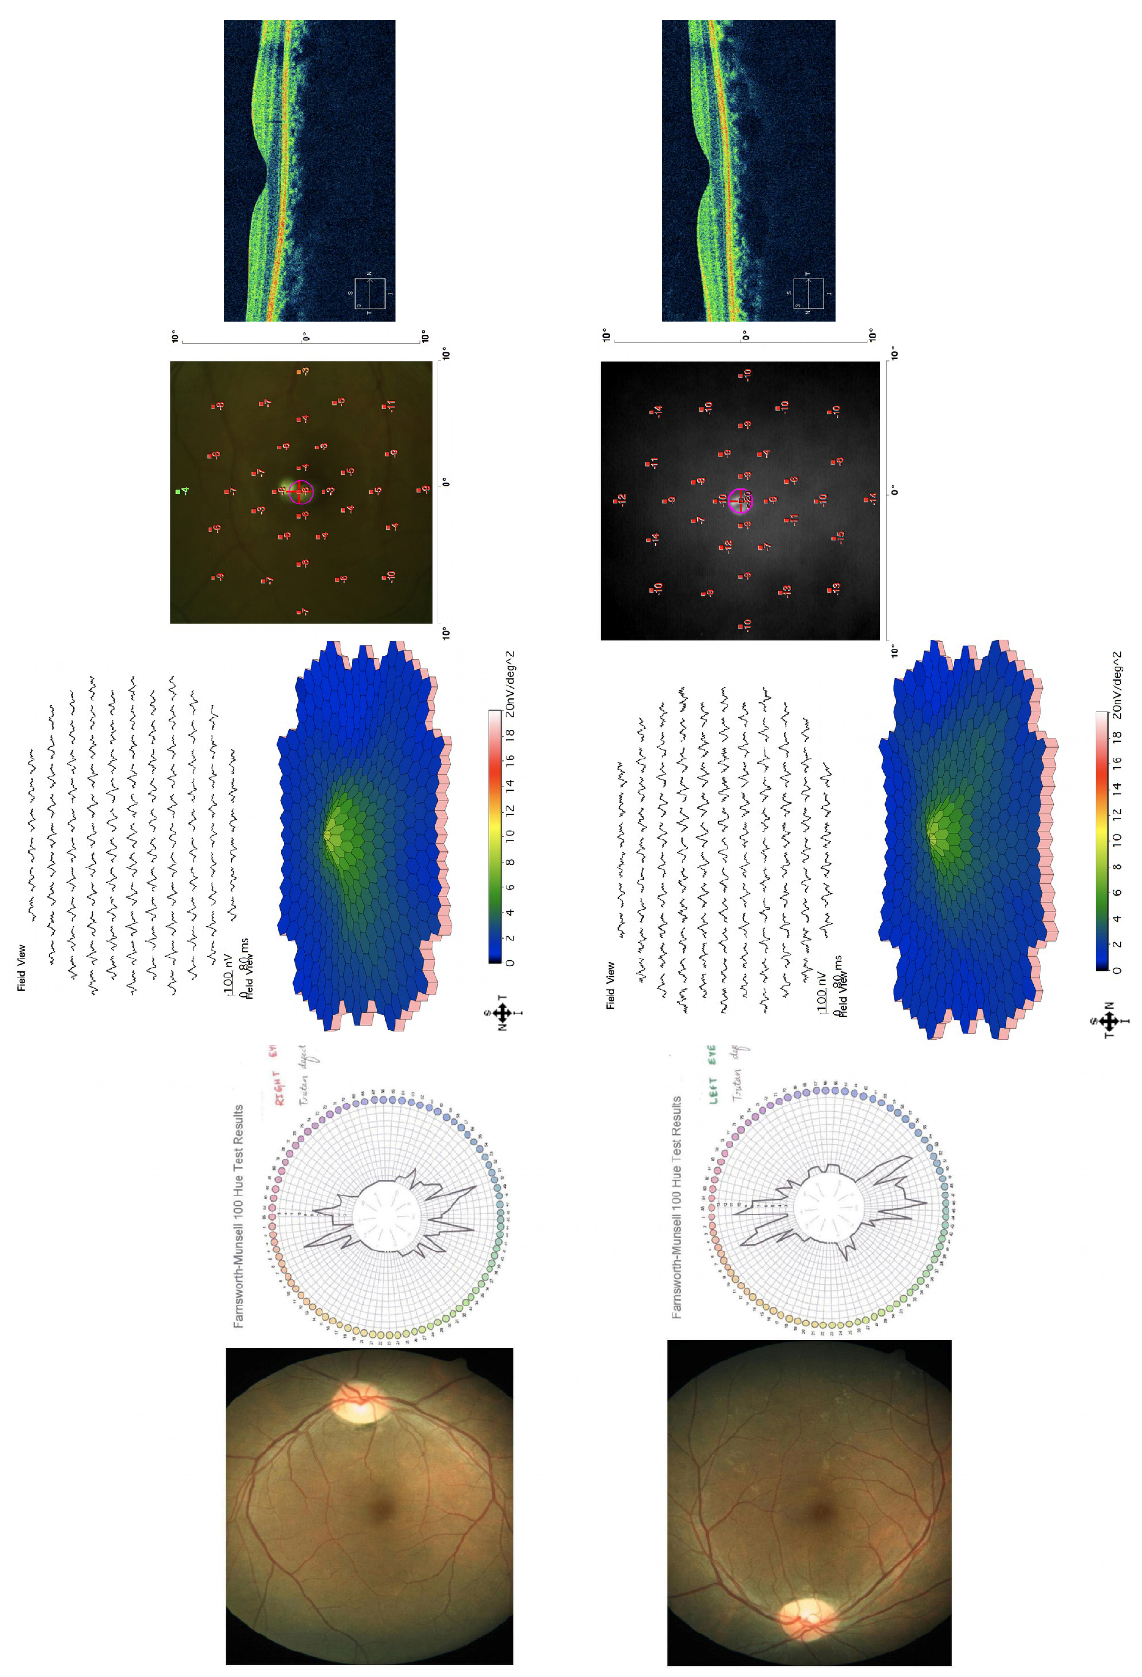
Figure 1: Fundus photograph, Farnsworth-Munsell 100 hue test, multifocal electroretinogram result, microperimetry and